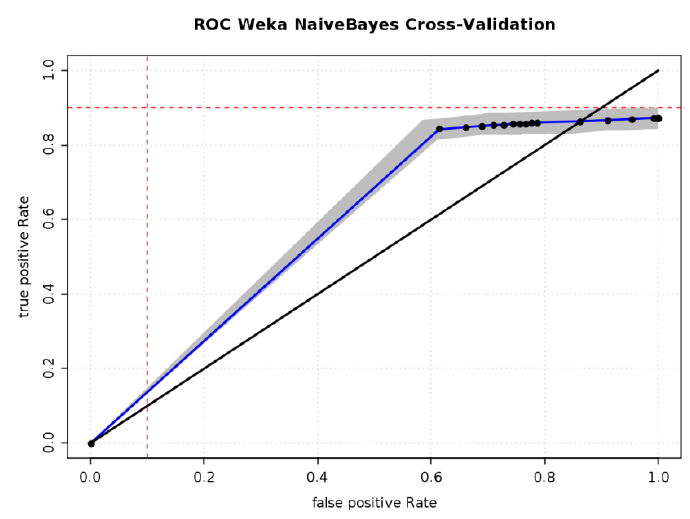
Figure 11. ROC-Curve for Naïve Bayes classifier.